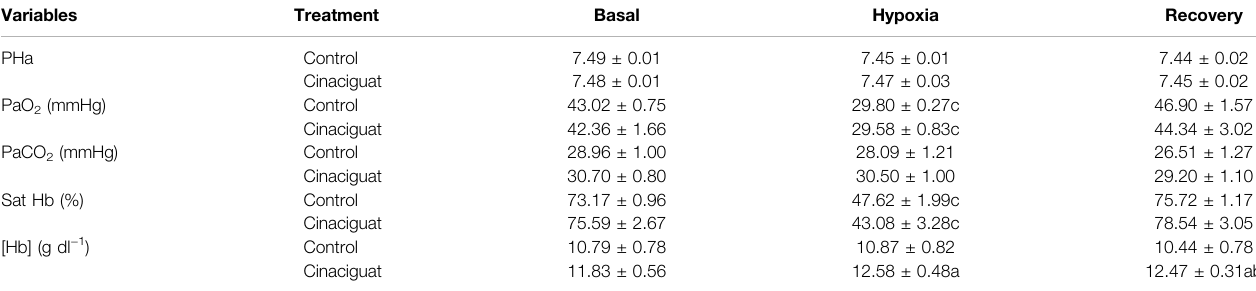
TABLE 2 | Aortic pH and arterial blood gases during a superimposed episode of acute hypoxia in chronically hypoxic and pulmonary hypertensive neonatal lambs.